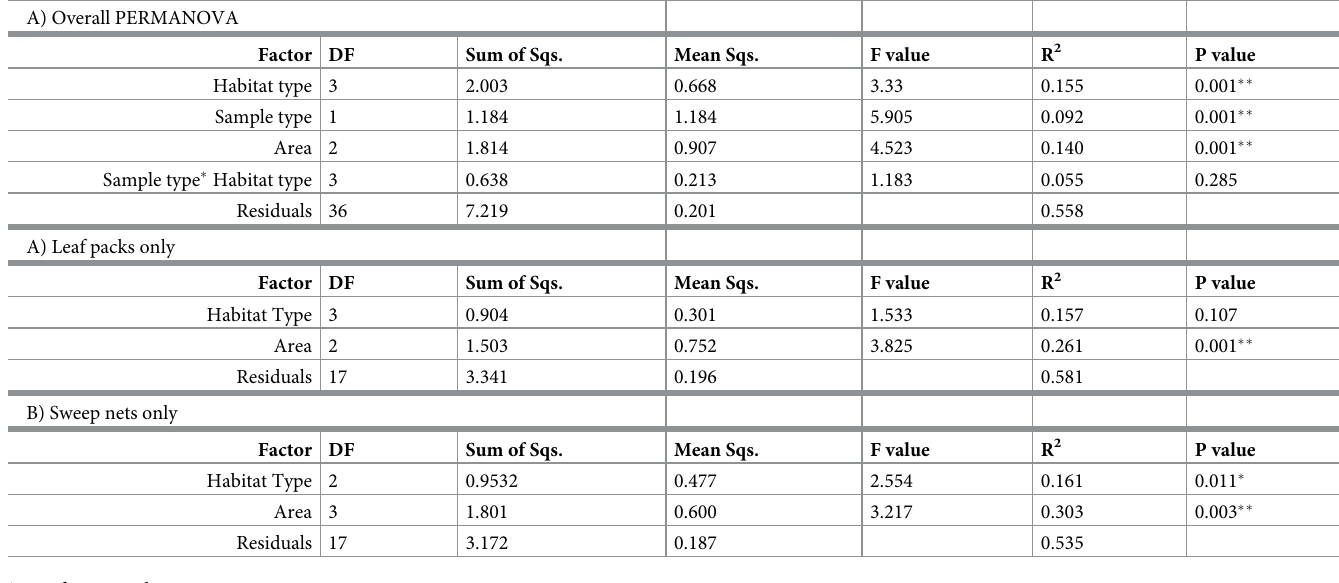
Table 5. Results of PERMANOVA performed on the entire data set and on subsets of the dataset using sweep nets only or leaf packs only. A) Overall